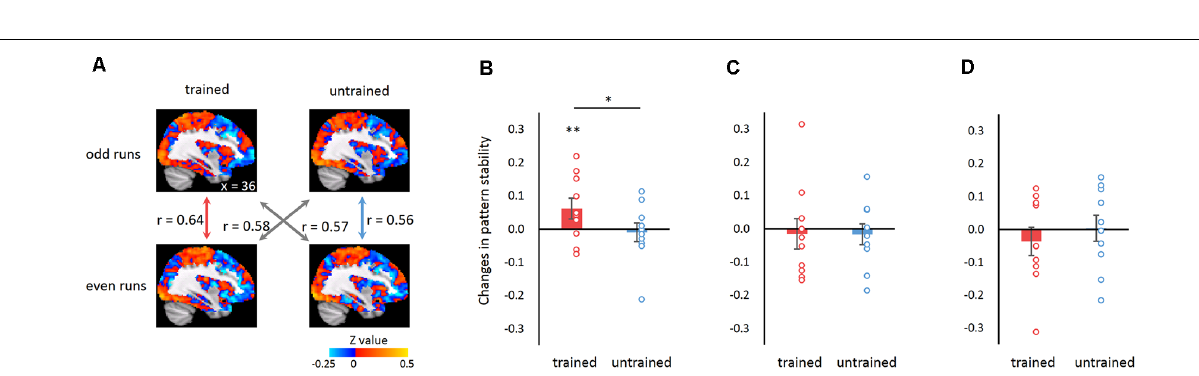
FIGURE 1 | Functional magnetic resonance imaging (fMRI) experimental task and data analysis. (A) In each trial of the fMRI experiment run, the finger-tapping sequence instruction was presented, followed by four flashes of the fixation point. Participants tapped their thumbs with the other four fingers as signaled by each flash. (B) Group-averaged BOLD response time courses during trials of each condition in the right primary motor cortex (M1). The hemodynamic responses returned to baseline at the eighth time point. (C) Illustration for segmenting and concatenating the event-related and the baseline periods. The data points represent the raw BOLD signal of M1 corresponding to four consecutive trials from one exemplar participant for illustration purpose. (D) The right M1 of an exemplar participant and the seed-based whole-brain connectivity map using this region as the seed.